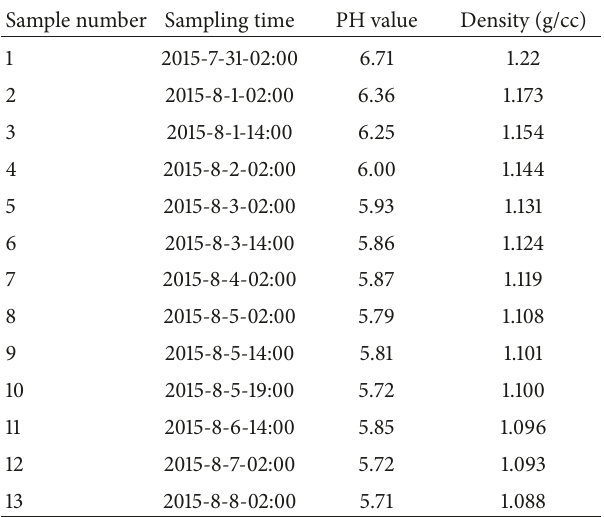
Table 1: PH values and densities of the flowback fluid in Tarim Oilfield in different flowback